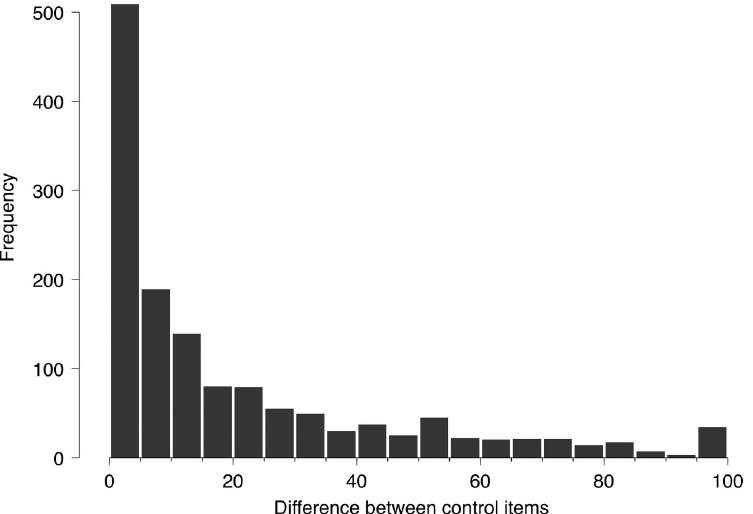
Fig 2. Distribution of difference between control items. Distribution of differences in item scores between two almost identically worded questions (#42 and #66) asking about the presence of a non-visual experience of "radiance". Item scores range from 0–100, so that the maximum possible difference is 100. N =